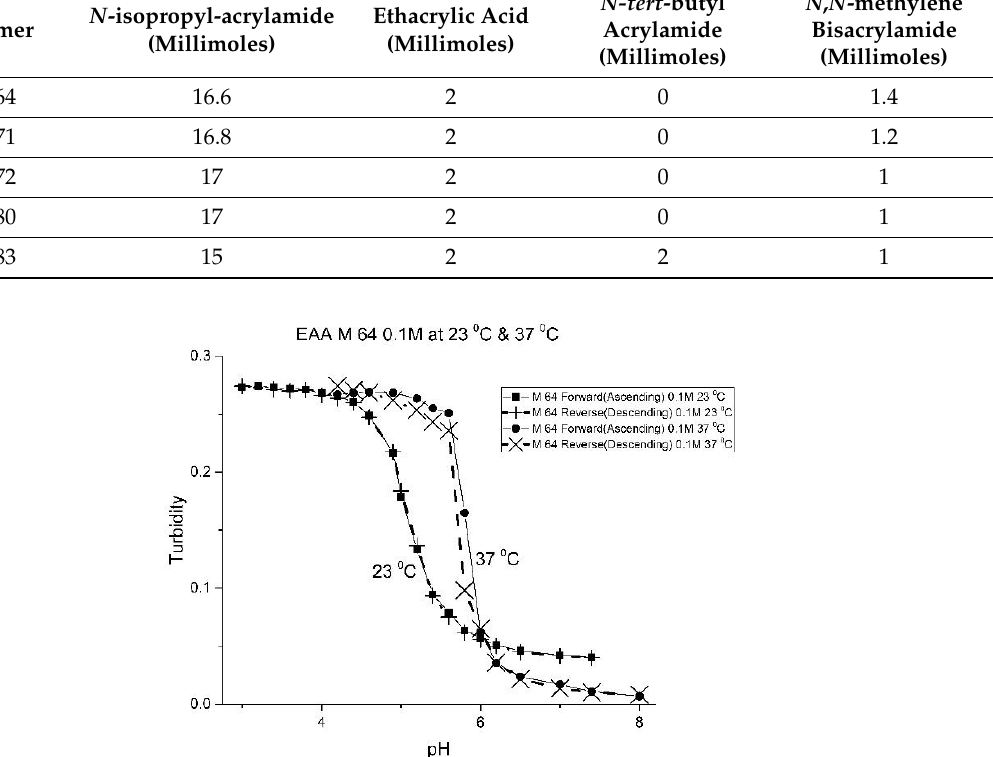
Table 5. pK a Values of N -isopropylacrylamide Copolymers of Ethyacrylic Acid.